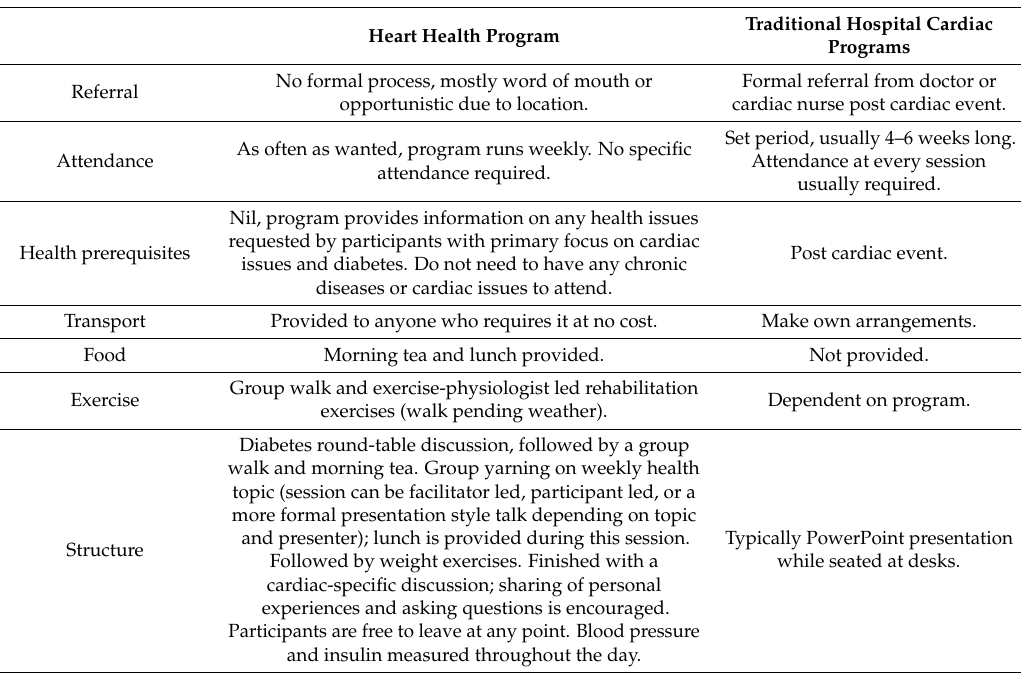
Comparison of the Heart Health program and traditional hospital cardiac rehabilitation